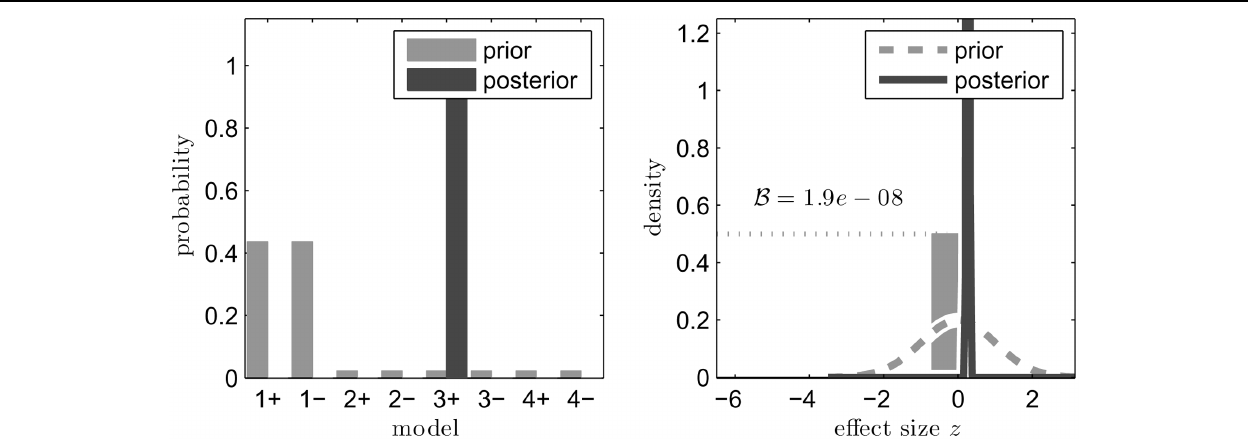
FIGURE 3 | Results of the Bayesian bias correction (BBC) reanalysis of the religious priming studies. In the (left) , we display the prior (gray) and posterior (black) probabilities of eight possible scenarios that result from the combination of four possible bias processes and two states of nature (to wit, that there is a real effect [ + ] vs. that there is no effect [–]). The greatest positive change, and the largest resulting posterior probability, is seen in model 3 + . This model includes a biasing process whereby non-significant results are published at a smaller, but nonzero rate. Additionally, it includes a true effect. The high posterior likelihood on this model implies that a true effect exists. In the (right) , we display the prior and posterior distributions of this effect size. The gray dashed line and gray bar indicate the prior distribution of the effect size, with a 50% probability of it being exactly 0 and a 50% probability of it being somewhere in the domain of the normal distribution. In the (black) posterior distribution, the point mass at 0 has vanished as the mass of the posterior has accumulated around 0.3. As a result, the Bayes factor favoring the null hypothesis is practically 0, indicating strong evidence for the alternative hypothesis that there is an effect of religious